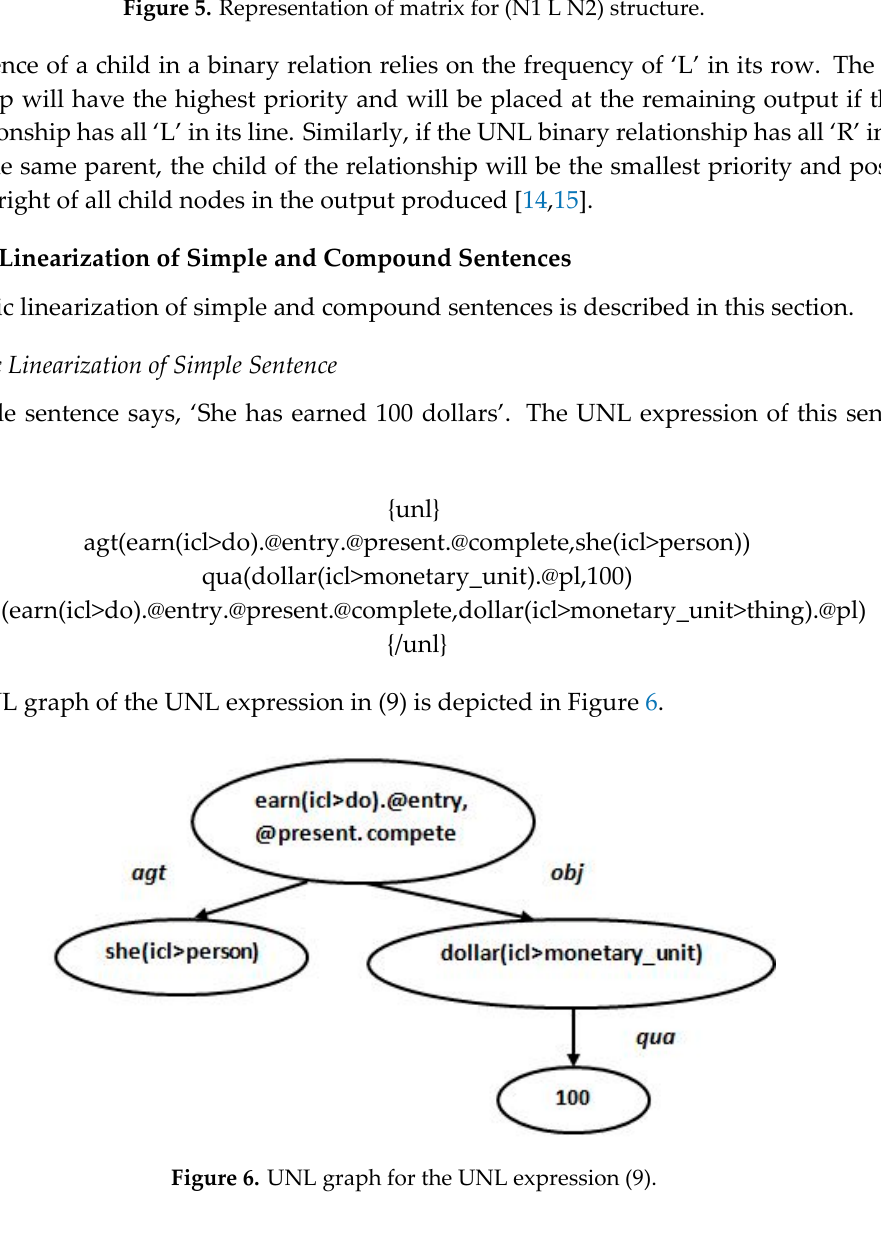
Figure 5. Representation of matrix for (N1 L N2) structure.